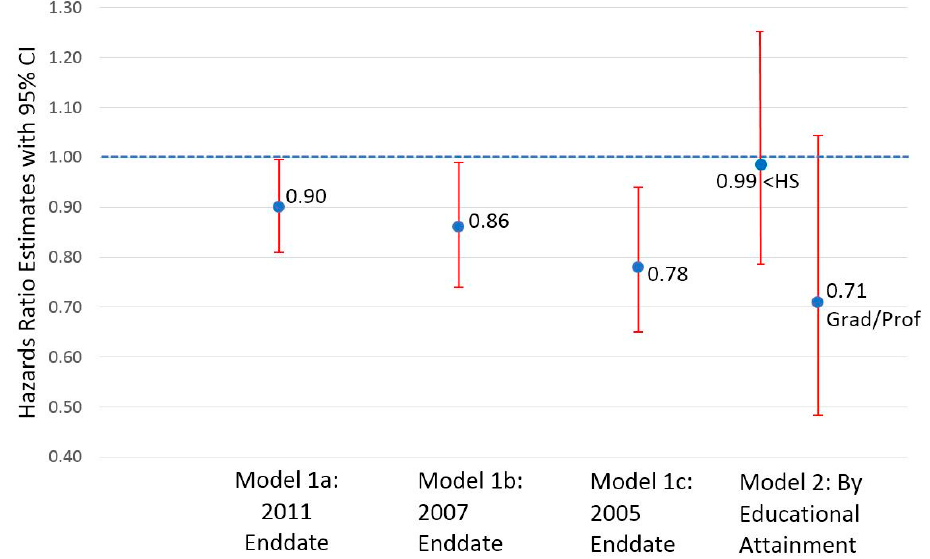
Figure 2. Hazard ratio estimates from Cox proportional hazards regression models for